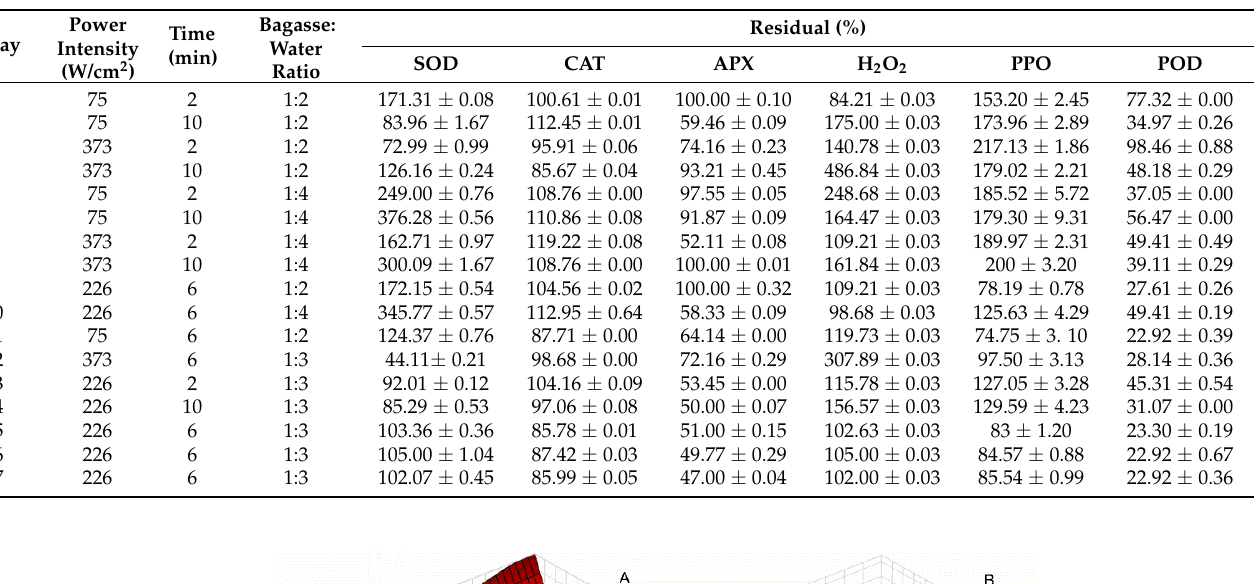
Table 2. Experimental design and S.O.D. (superoxide dismutase), C.A.T. (catalase), A.P.X. (ascorbate peroxidase), P.P.O. (polyphenol oxidase), and P.O.D. (peroxidase) activities and H 2 O 2 content after sonication of cashew apple bagasse puree.